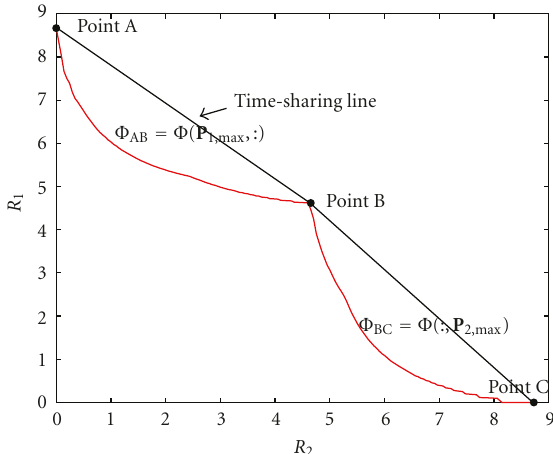
Figure 2: Achievable rate region for the MIMO interference channel—averaged over 2000 channel